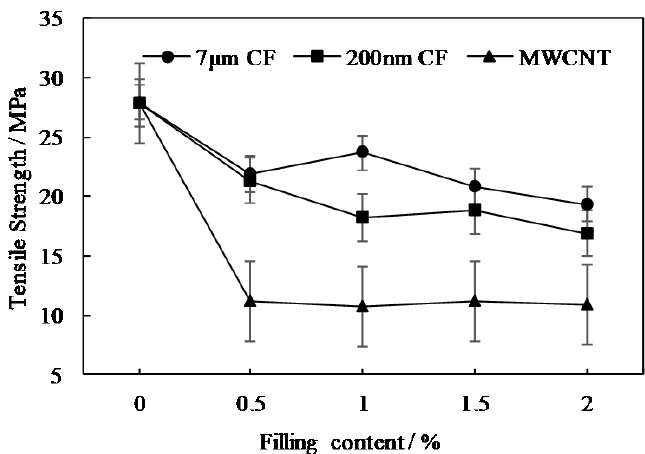
Figure 8. Tensile strength of micro/nano CF and MWCNT modified PTFE composites.